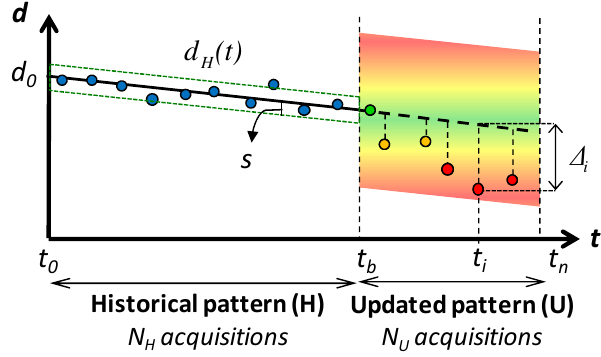
Fig. 2. Estimation of the Deviation Index DI 1 through the compari- son of pattern U with its prediction derived by using pattern H Figure 2. Estimation of the Deviation Index DI 1 through the comparison of pattern U with its 615 prediction derived by using pattern H . 616